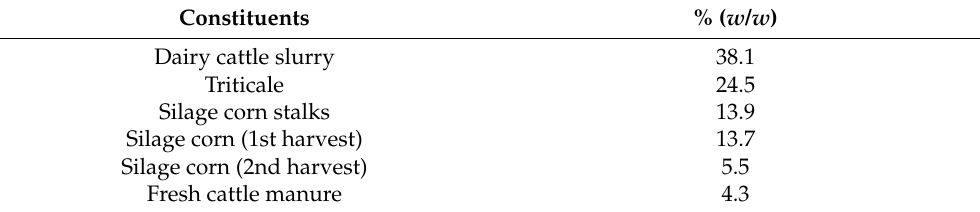
Table 1. Biomethane plant feeding materials.